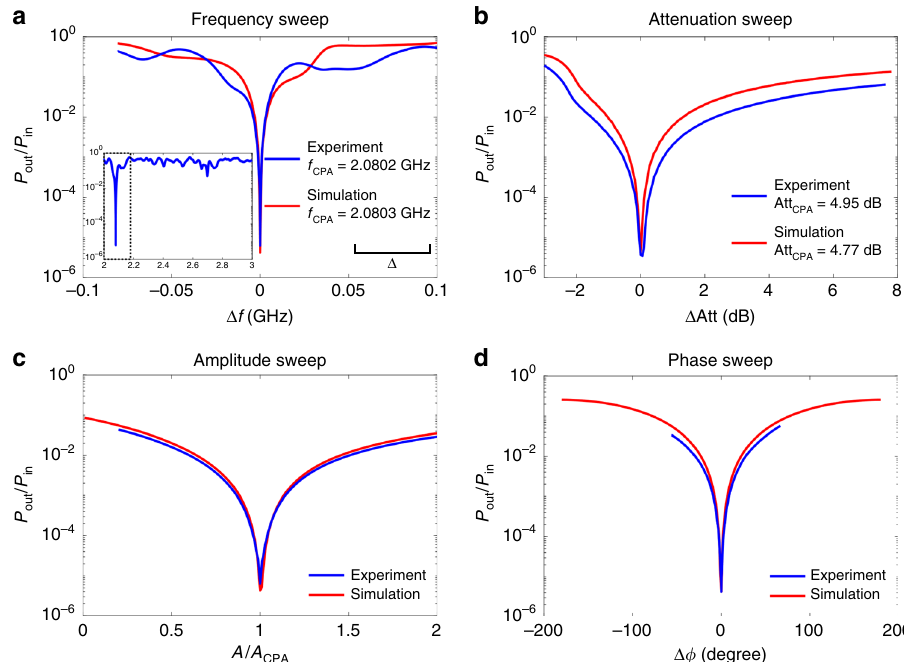
Fig. 6 Evidence of CPA in the complex network with BTRI under four independent parametric sweeps. Plots are normalized so that CPA conditions are in the center of the parameter variation range. The closest CPA frequency condition for the simulation is plotted along with the experimental data. a Measured ratio of output power P out to input power P in as the microwave frequency sent into both ports of the graph is simultaneously swept near the CPA frequency ( Δ f = f − f CPA ). Inset shows the output-to-input power ratio response for a larger frequency range around the resonance, and the dashed box corresponds to the frequency range shown in a . The output-to-input power ratio shows a sharp dip below 10 − 5 at the CPA frequency ( f CPA ) in both experiment and simulation. The scale bar of the mean mode spacing Δ is shown in the plot for reference. b Output-to-input power ratio obtained by varying the attenuation of the variable attenuator in the graph, while the other waveform characteristics (CPA frequency and waveform) are equal to the ones set in a . Δ Att is the attenuation normalized by Att CPA from the CPA condition. Output-to-input power ratio obtained by changing the amplitude A ( c ) and phase difference Δϕ ( d ) separately of the two excitation signals required for the CPA state. All experimental results are obtained by direct measurement of the input and output RF